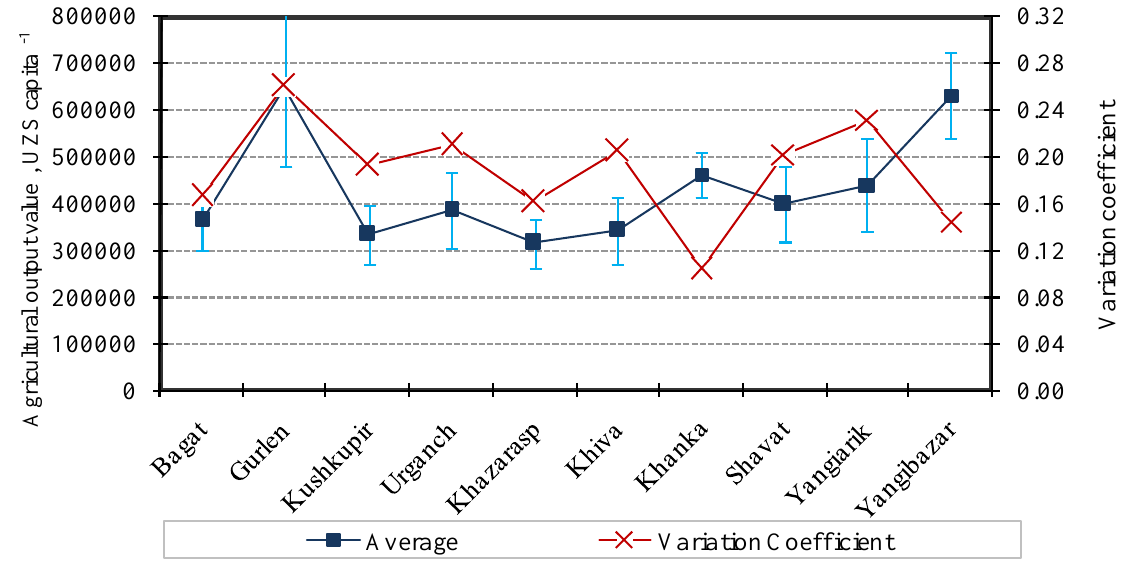
Figure 13. Mean and variation in per capita agricultural revenue over districts,